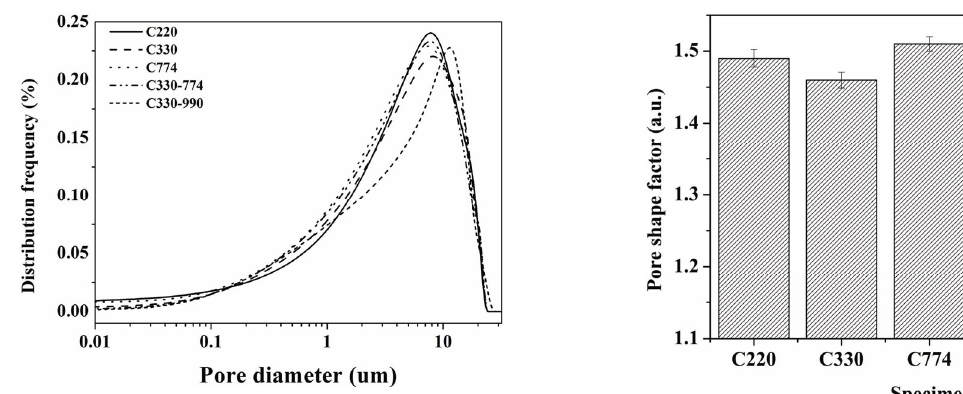
Fig. 2 Pore size distribution of porous alumina ceramics. Table 3 Mean pore size, pore roundness, < 2 μ m pore area, and > 18 μ m pore area of the specimens Specimen